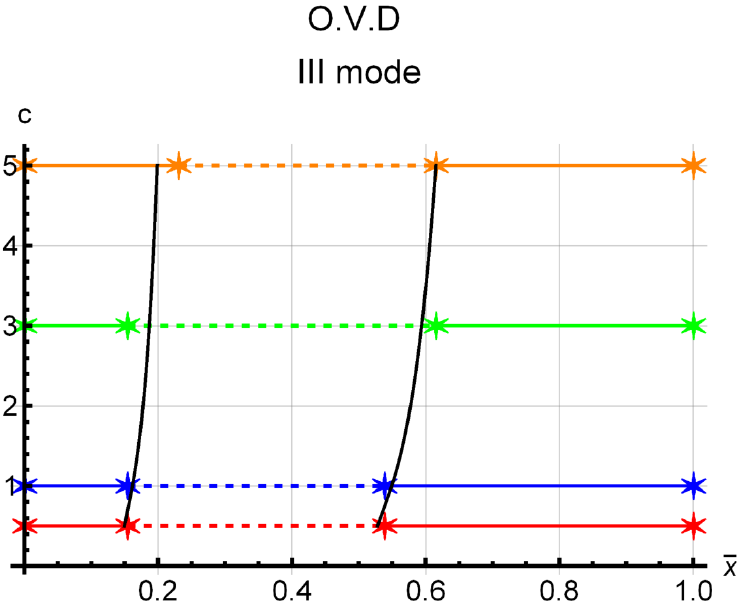
Figure 12. Analytical and numerical optimal voltage distributions (O.V.D.) for the third eigenmode excitation versus tapering ratio. Black lines highlight the analytical location of the points beyond which the voltage should be applied with the opposite phase with respect to the previous region. The dashed lines identify the PZT couples that have to be supplied with the opposite voltage sign. The stars represent the numerical optimal voltage distribution for each c value, calculated considering 13 PZT